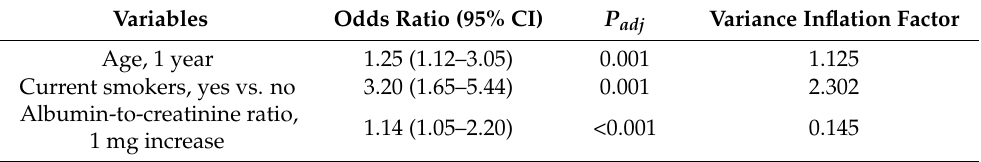
Table 3. Correlates for the presence of artery disease in patients with hernias.